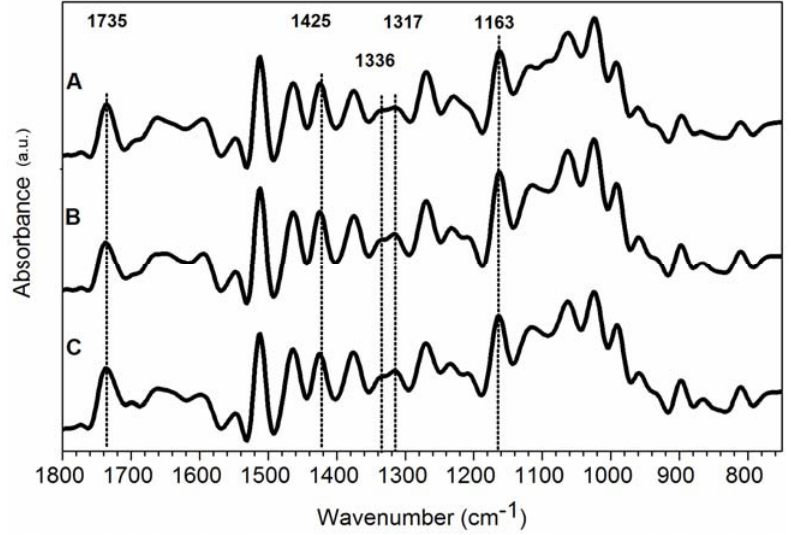
Figure 3. Deconvoluted Fourier transform infrared (FT-IR) spectra of coated wood samples. ( A ) control; ( B ) sample exposed to natural weathering; ( C ) sample artificially weathered.